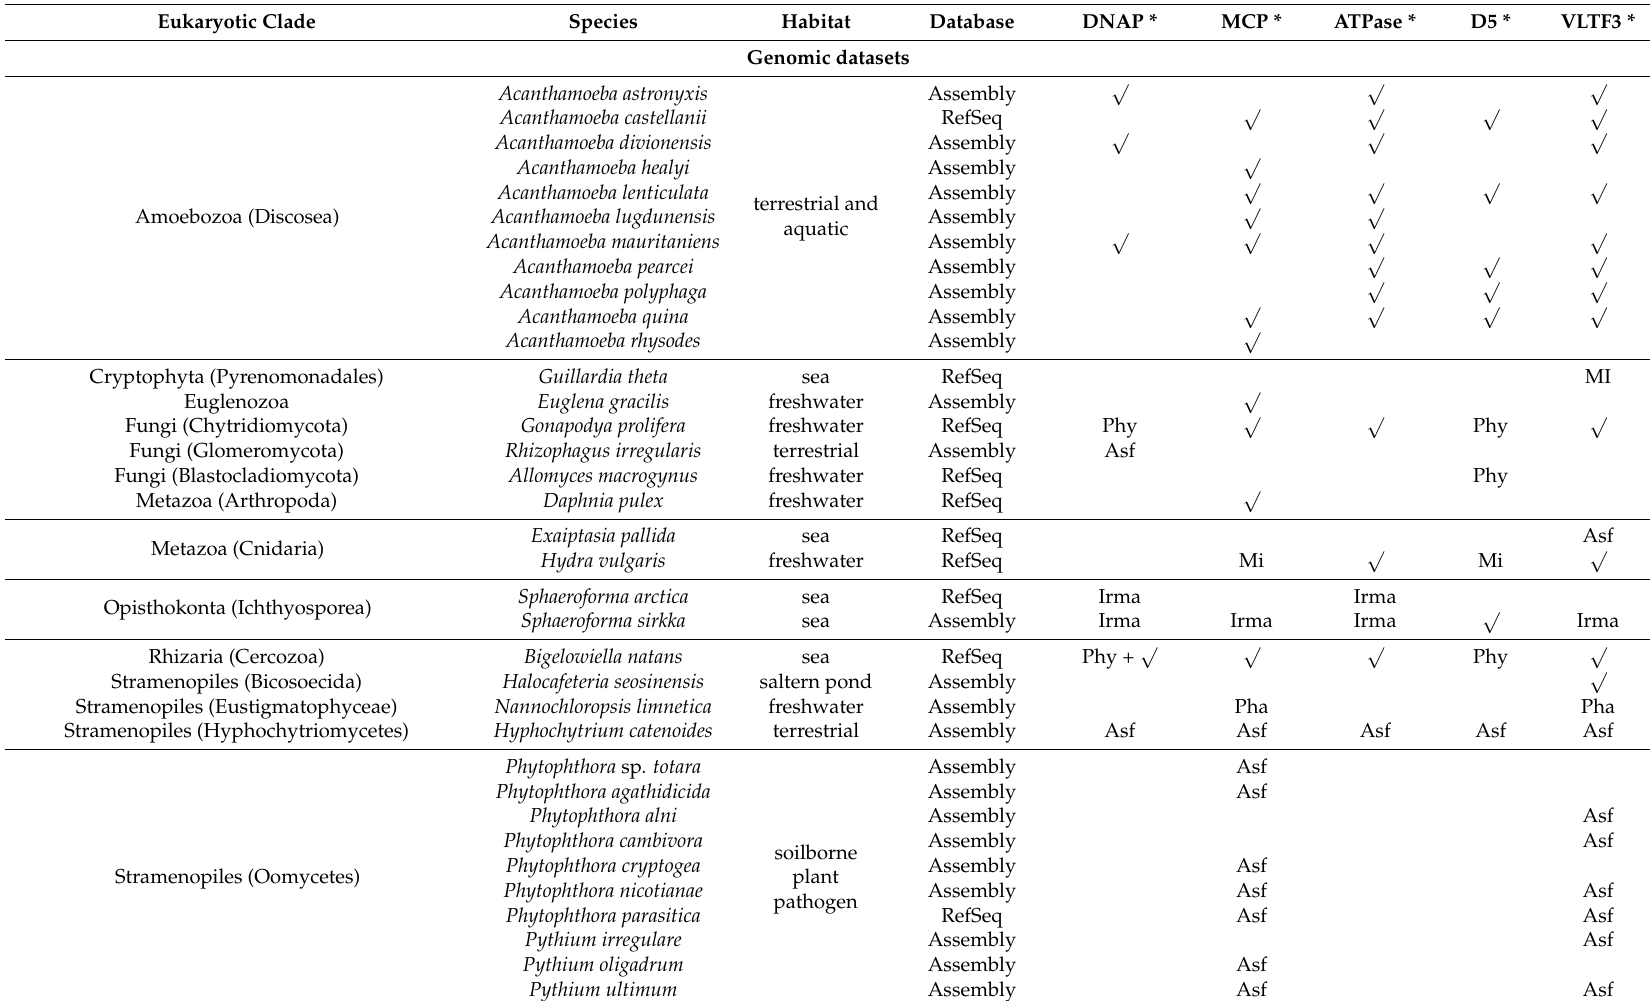
Table 1. Nucleocytoplasmic large DNA viruses (NCLDV) core protein homologs in eukaryotic sequence